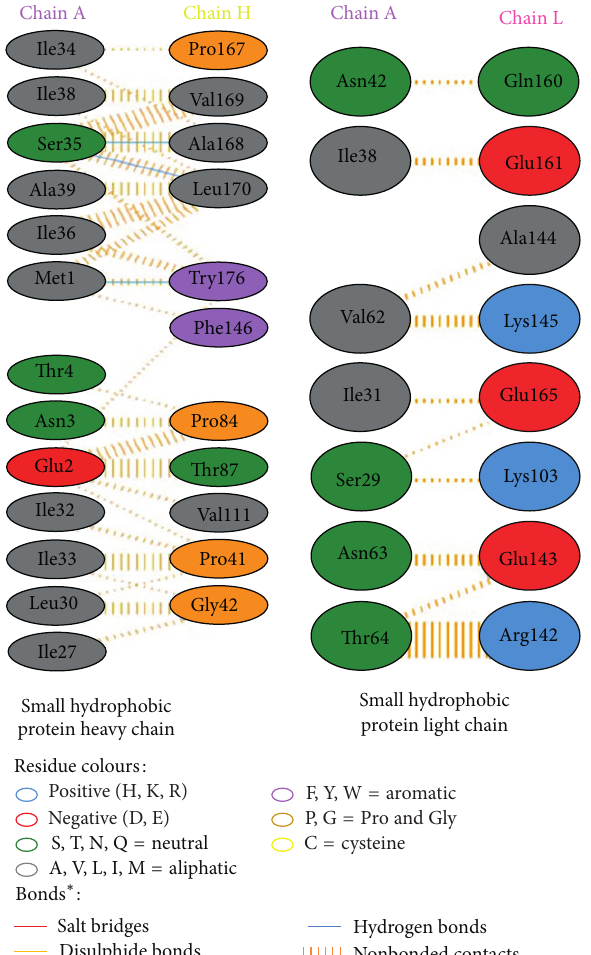
Figure 7: Interaction of small hydrophobic protein and motavizumab showing interaction of residues with heavy and light chain through various bonds ∗